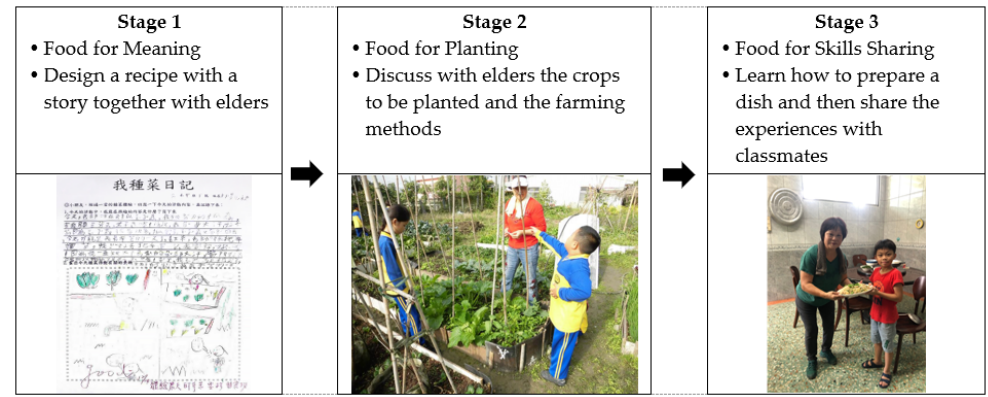
Figure 3. The three stages of integrating intergenerational education into the FAE program.